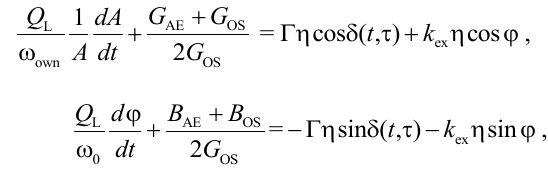
Fig. 1. The equivalent circuit diagram of SAD. The equivalent sources of instantaneous current j represent the effect on AD of an external synchronising signal and a signal on the oscillator load caused by the reflected proper emission delayed by time τ , relatively.